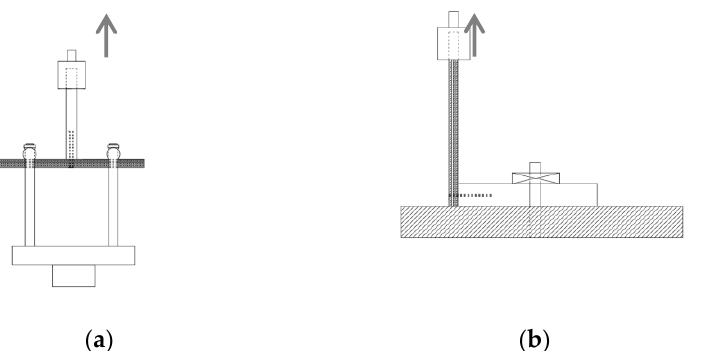
Figure 3. Schematic diagram of experimental load loading ( a ) method of testing the edge withdrawal strength of staples; and ( b ) method of testing the lateral holding strength of staples.